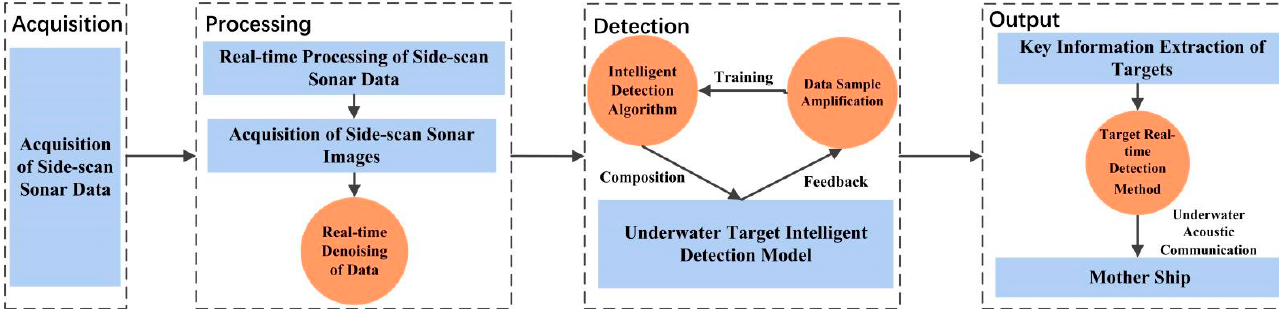
Figure 3. Real-time underwater-target detection process based on an AUV equipped with SSS.